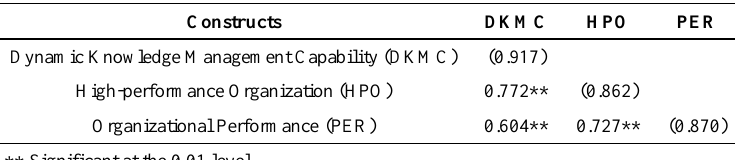
Table 3. Discriminant Validity Analysis